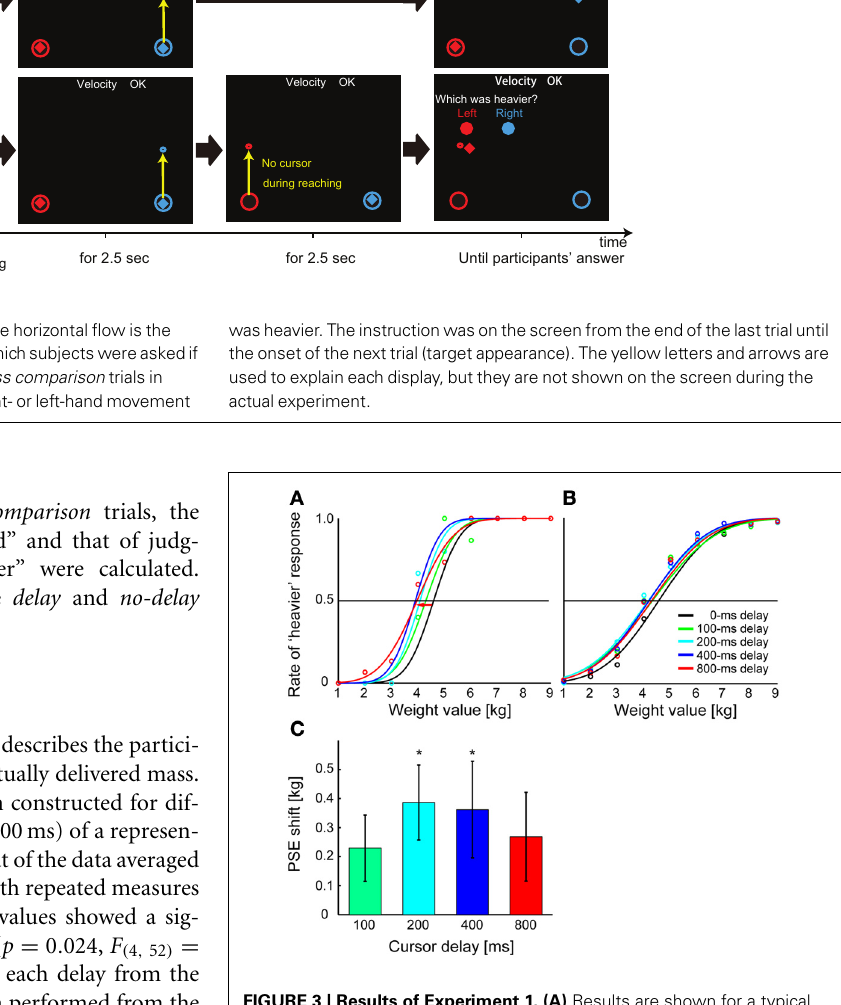
FIGURE 3 | Results of Experiment 1. (A) Results are shown for a typical participant. The mass value at which each curve crosses the 0.5 line is PSE for each delay value. The red arrow indicates the shift of PSE for a 800-ms delay from that for a 0-ms delay (see panel C ). (B) Psychometric functions are fitted to data averaged across participants. Average judgment rate across participants was calculated for each mass value, and sigmoid functions were fitted to the averaged rates. (C) For each delay, the shift of PSE from that for a 0-ms delay is shown. Shifts were calculated for each cursor delay and averaged across participants. Error bars indicate standard error of measures across participants. * p < 0 . 05 according to Ryan’s multiple (four) comparison tests for difference in PSE between 0-ms delay and the other delay